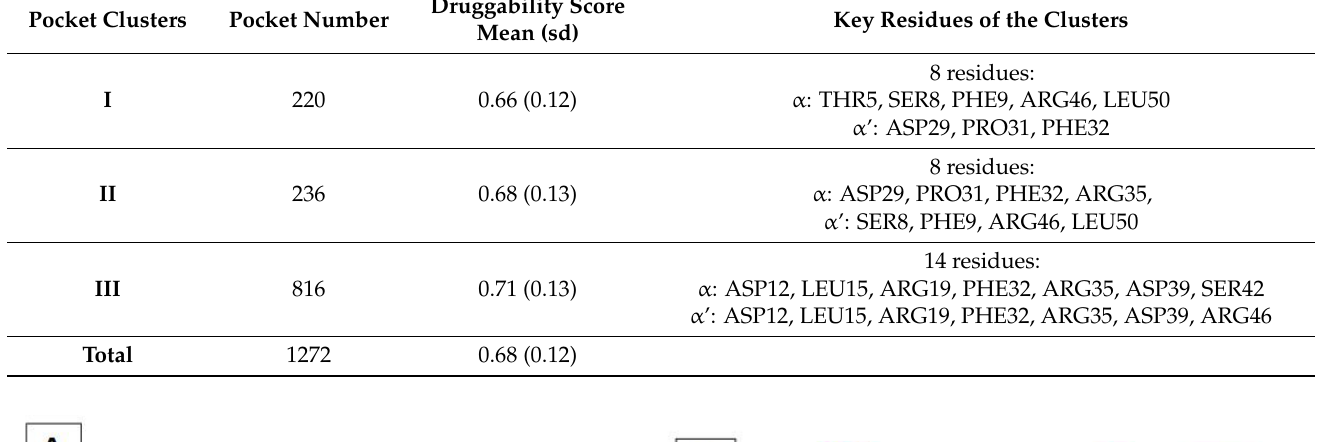
Table 2. Table of the three groove-druggable binding sites (I, II, III). Total pocket number observed in different clusters or binding sites. Average druggability score of pockets associated with each binding site and its corresponding standard deviation (sd). Key residues observed in more than 75% of the cluster of druggable pockets for each binding site are listed.